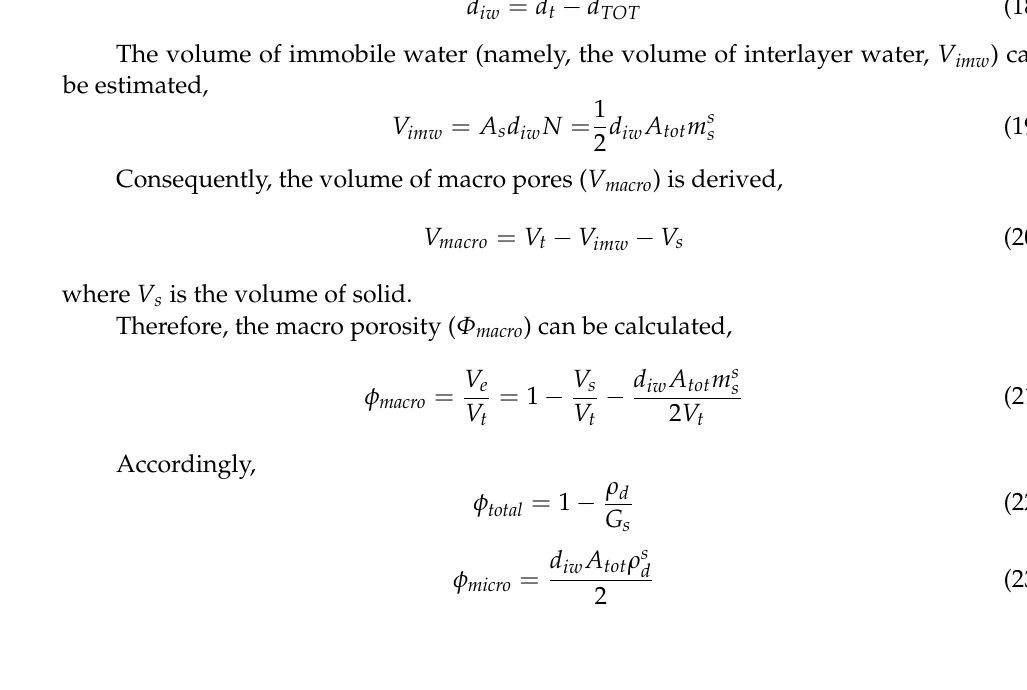
where m s is the mass of solid (kg), m w is the mass of water (kg), ω is the water content (kg/kg), ρ w is the density of water (kg/m 3 ), V t is the total volume of the sample, V w is the volume of total water in the sample (m 3